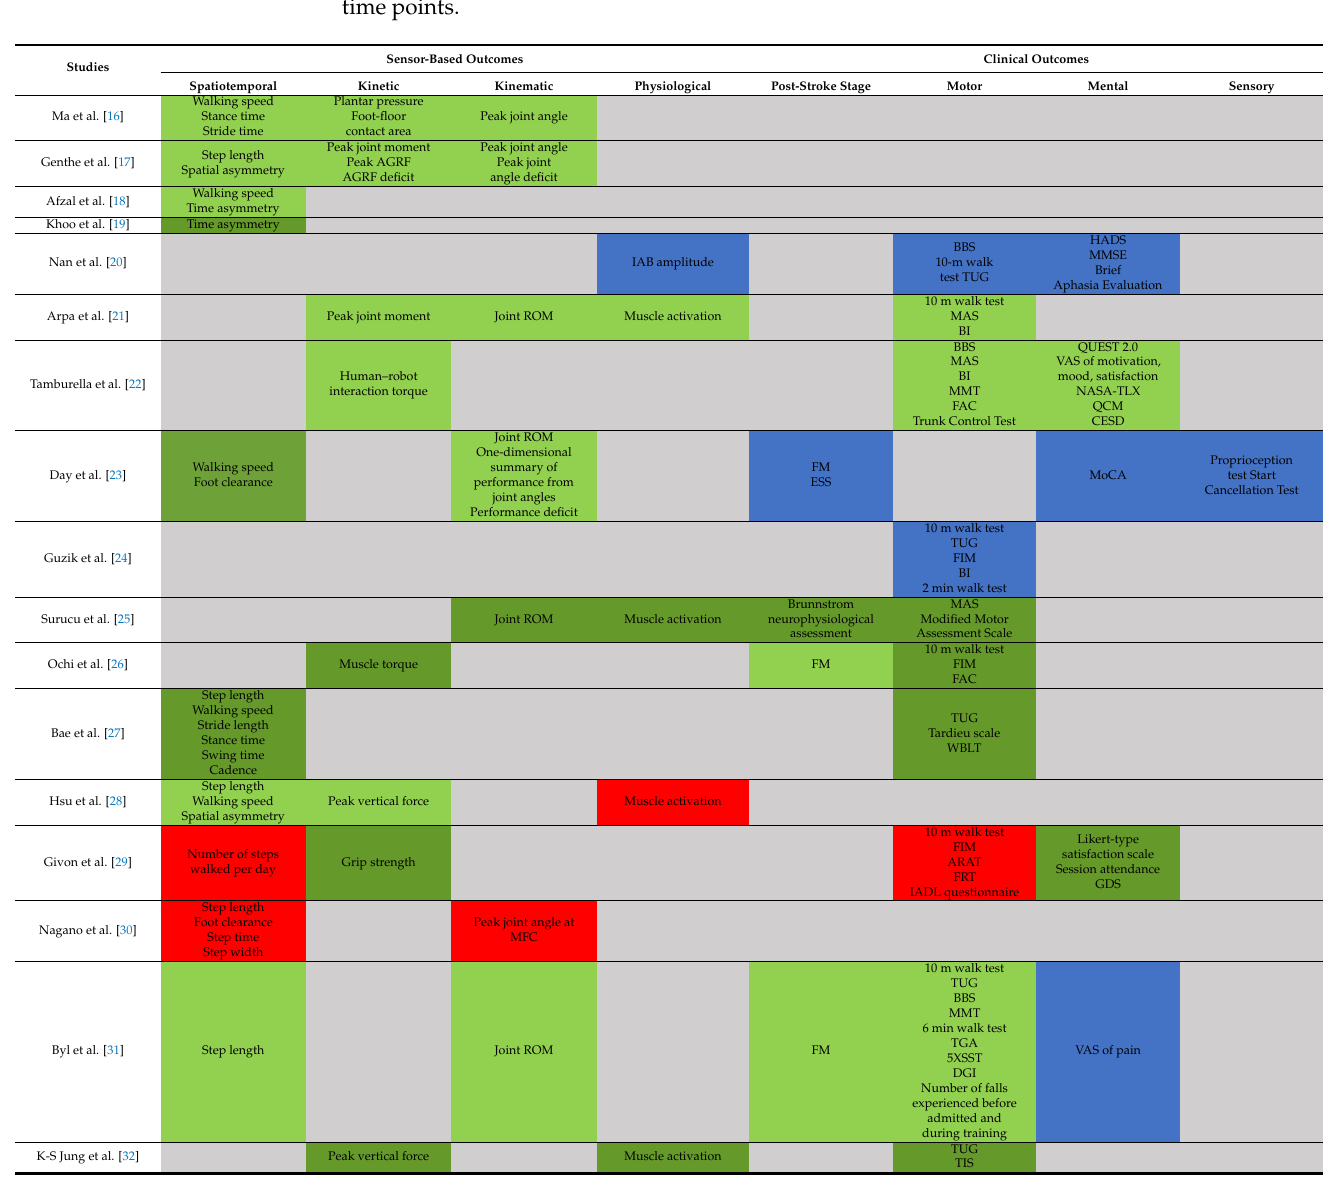
Table 3. Outcomes and BS effects on post-stroke recovery: grey indicates non-measured outcomes, blue shows the non-statistically evaluated outcomes, green addresses the condition when at least one measured outcome statistically significantly improved between at least two evaluation time points, dark green corresponds to the condition when at least one measured outcome statistically significantly improved between at least two evaluation time points and the improvement was higher on the experimental group than the control group, and red refers to the condition when none of the measured outcomes demonstrated statistically significant improvements between all evaluation time